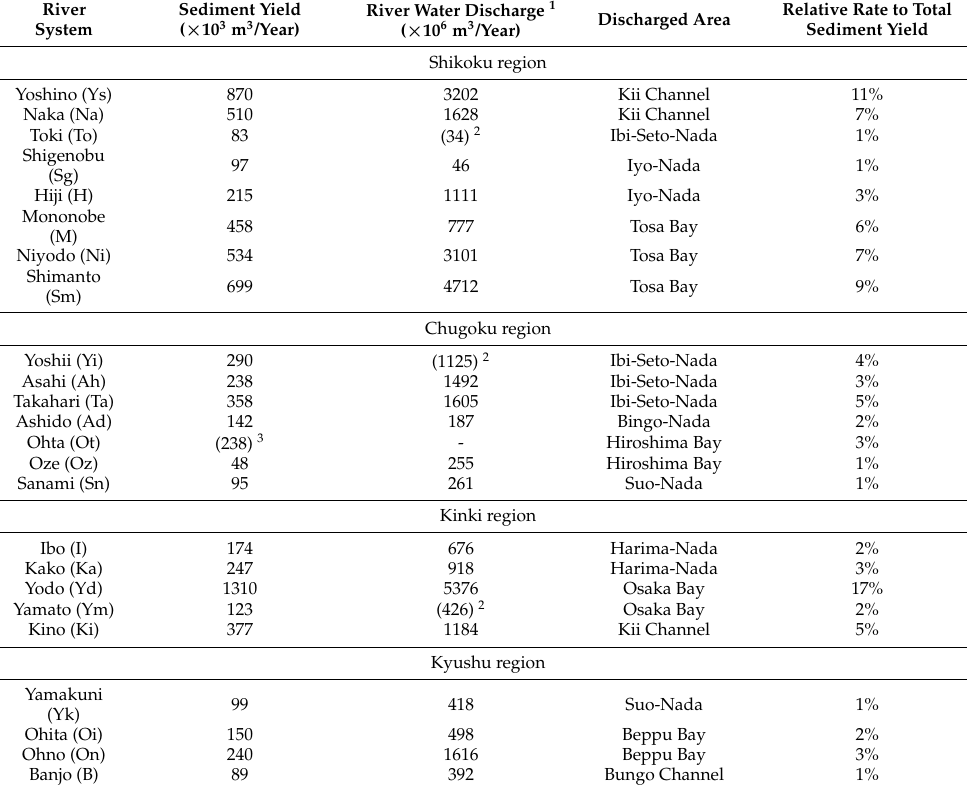
Table A1. Sediment yield and river water discharge data in each river system of the study